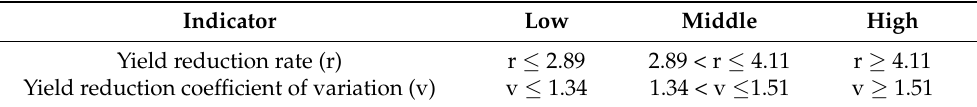
Table 1. Classification standard for yield reduction rate and yield reduction coefficient of variation